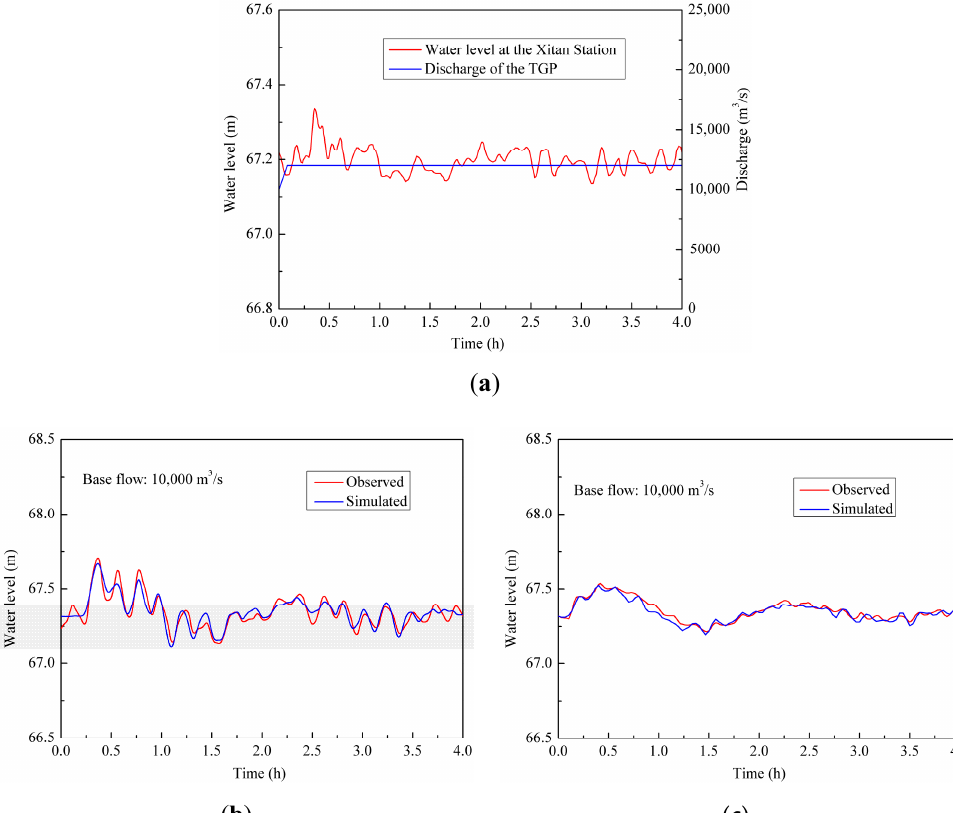
Figure 6. Boundary conditions and the simulated versus the measured water surface elevation. ( a ) Boundary conditions; ( b ) Water level at the lower lock head of the ship lift; ( c ) Water level at the entrance of the approach